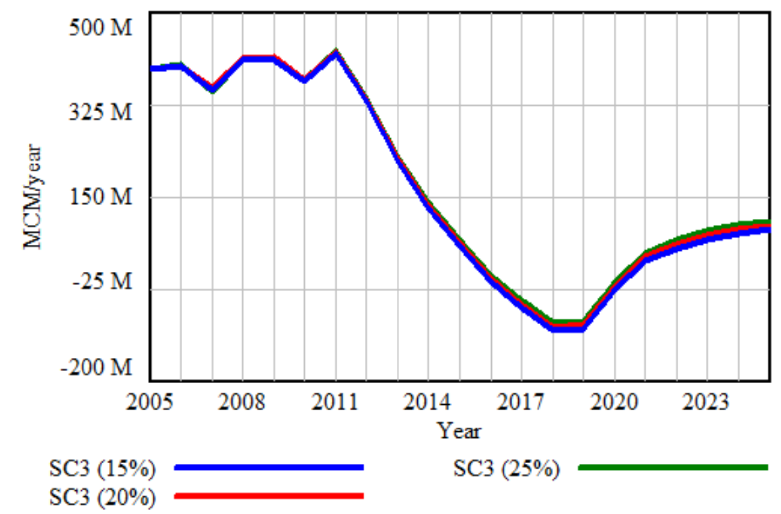
Figure 12. Impact of leakage control on water conservation.